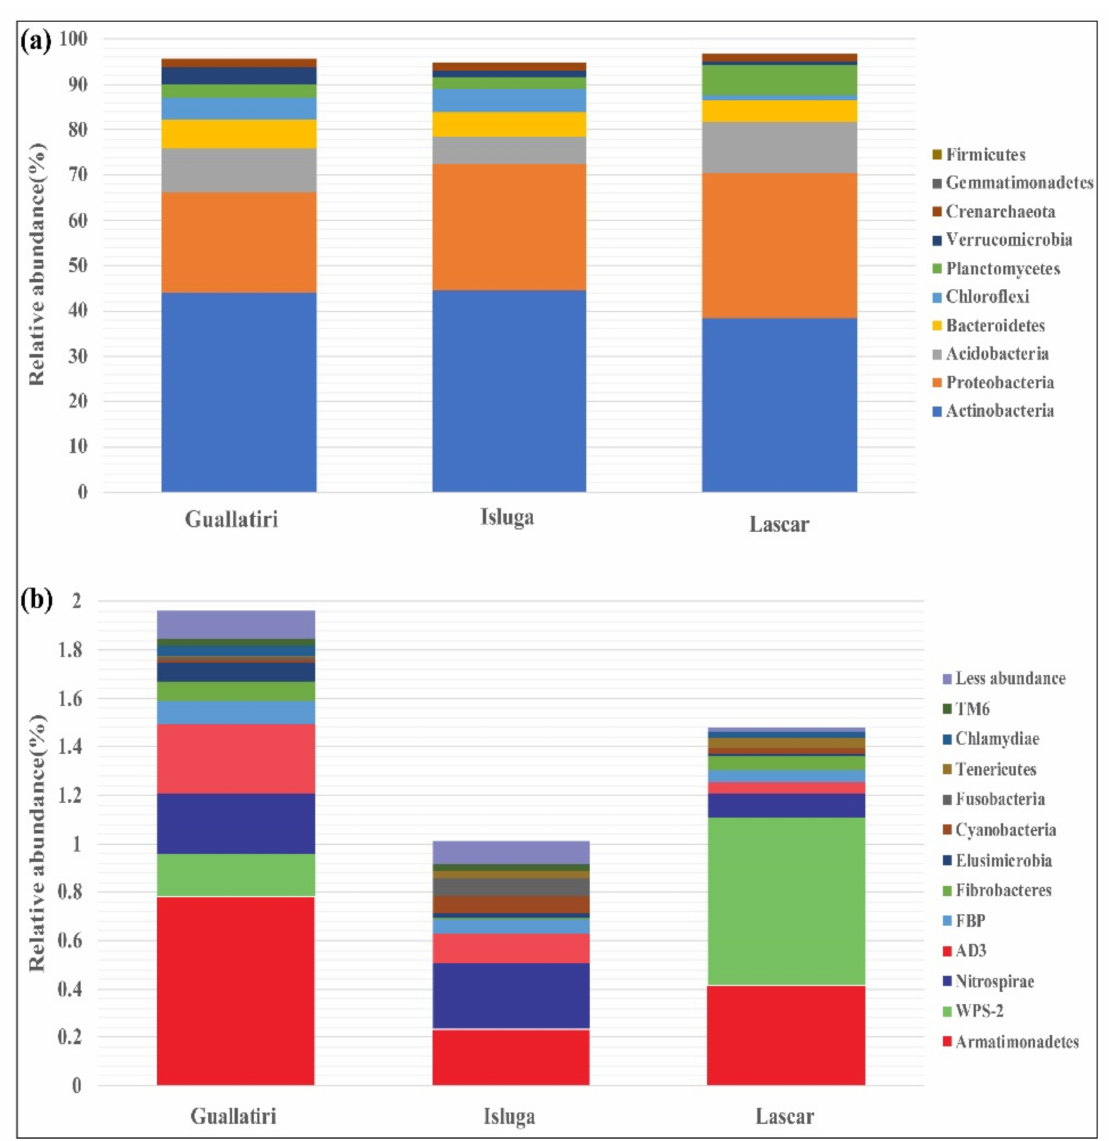
Figure 2. Mean relative abundances of major ( a ) and minor ( b ) phylum-level taxa of total rhi- zobacterial communities from P. quadragularis grown on the slopes of the Guallatiri, Isluga, and Lascar